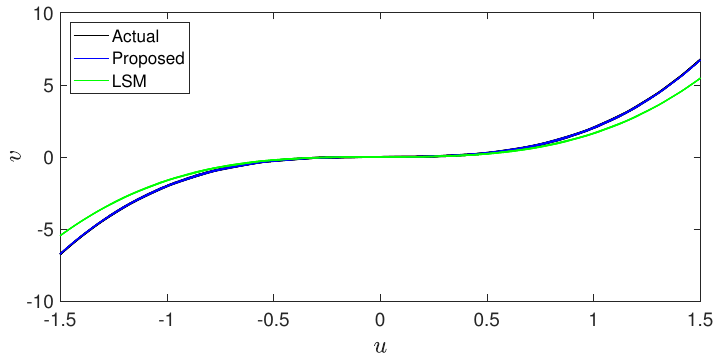
Figure 9. Comparison of the nonlinear static function for Example